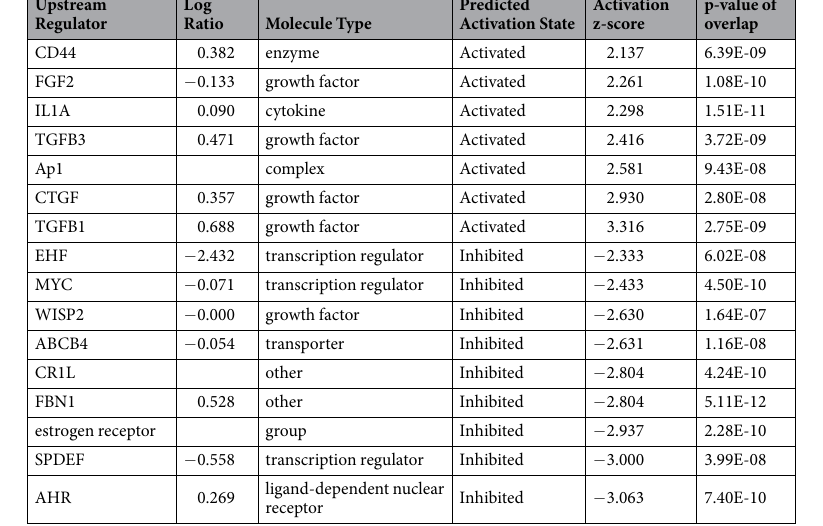
Table 1. Activated/Inhibited Upstream Regulators (Ingenuity) PT vs .N.